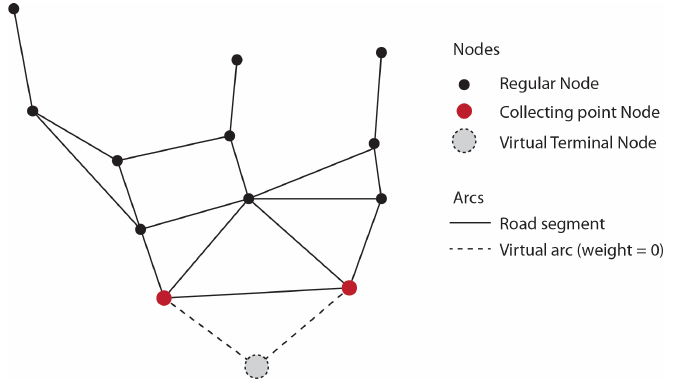
Figure 8. Conceptual representation of a road network, with regular nodes representing intersections between road segments. Collecting-point nodes are terminals for timber transportation. Best path and best collecting node are chosen by inserting a virtual terminal node that is linked with virtual arcs to collecting points.